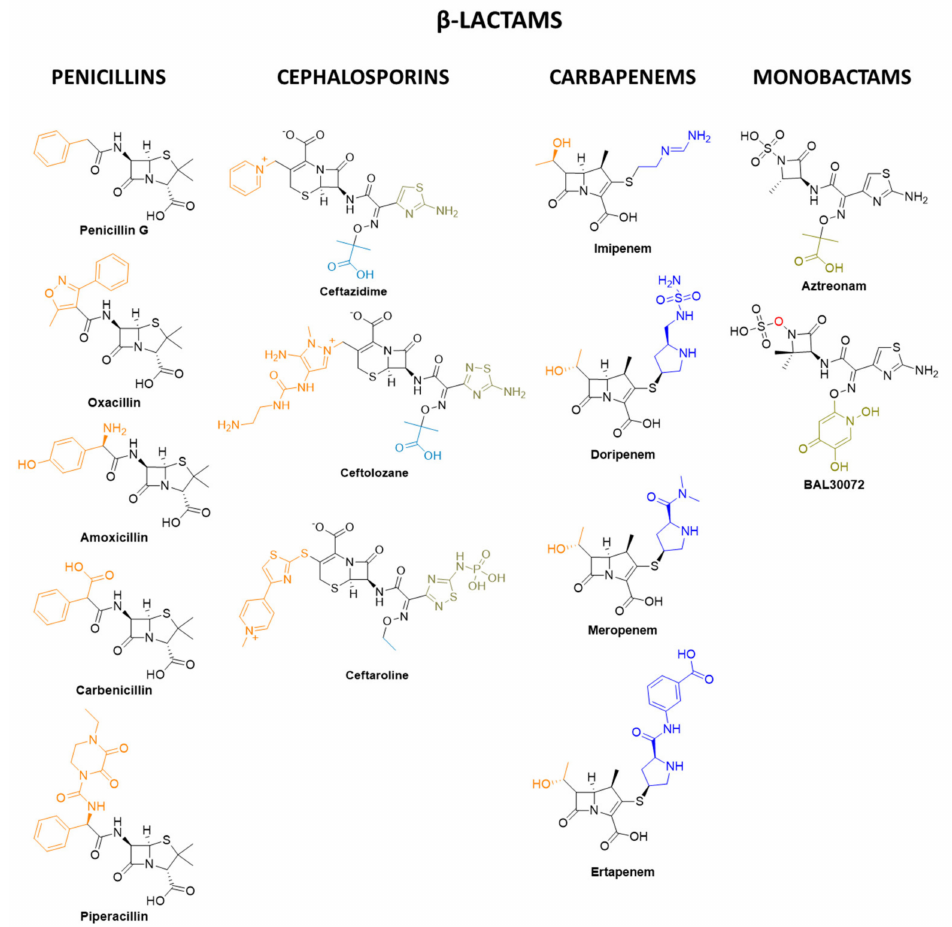
Figure 12. Structure of representative penicillins (penicillin G, oxacillin, amoxicillin, carbenicillin, and piperacillin); cephalosporins (ceftazidime, ceftolozane, and ceftaroline); carbapenems